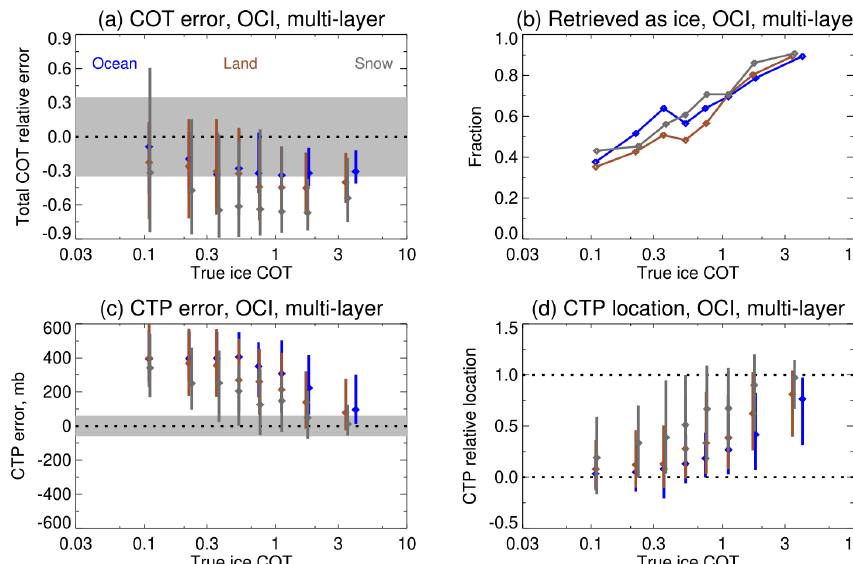
Figure 17. Retrieval performance binned as a function of ice COT for the simulated multi-layer cloud systems for OCI. Blue, brown, and grey indicate ocean-like, land-like, and snow-like simulations. The left column shows retrieval errors for (a) total (liquid plus ice) COT and (c) CTP. In these panels points indicate the median retrieval error, vertical lines the central 1 σ of results within each bin, the dotted line an error of zero, and grey shading the PACE mission goal uncertainties: 35% for ice-phase COT and 60mb for CTP (the latter for COT ≥ 3 only). Panel (b) shows the fraction of data where the best-fit cloud optical model was ice. Panel (d) shows the median (points) and central 1 σ (lines) of the retrieved CTP’s location relative to the lower- and upper-cloud-layer CTPs (dotted lines at 0 and 1